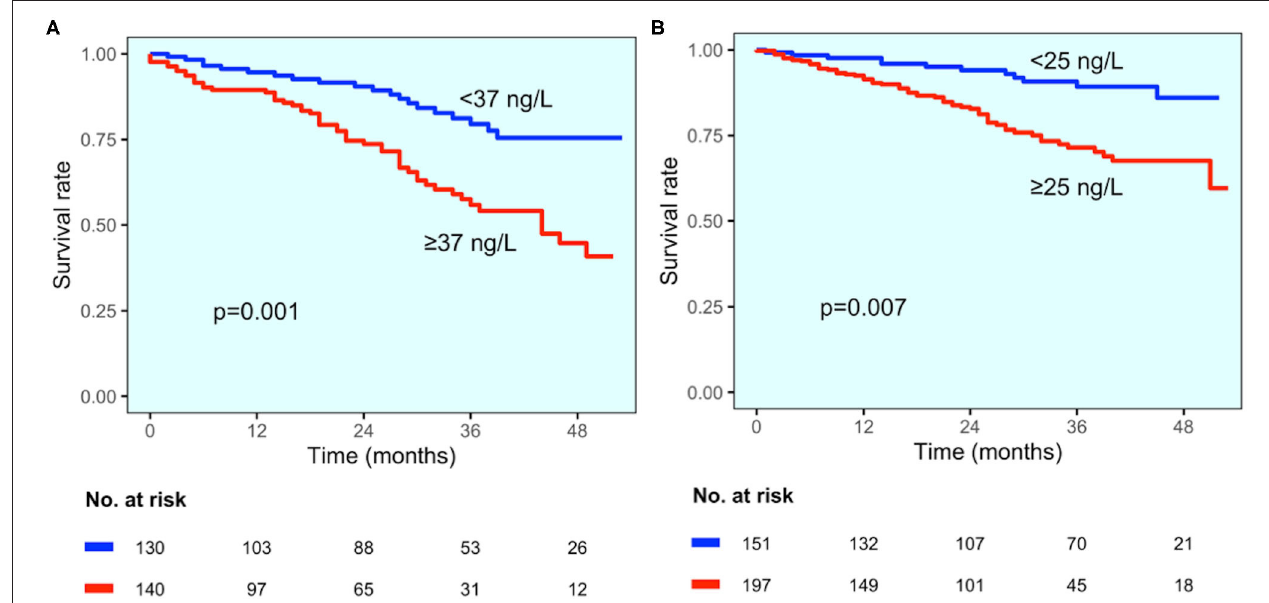
FIGURE 5 | All-cause mortality according to CAD status. Kaplan–Meier curves for all-cause mortality for patients with established CAD diagnosis ( A ) and those without CAD diagnosis ( B ), stratified by hs-TnT cut-off values (37 and 25 ng/L, respectively).